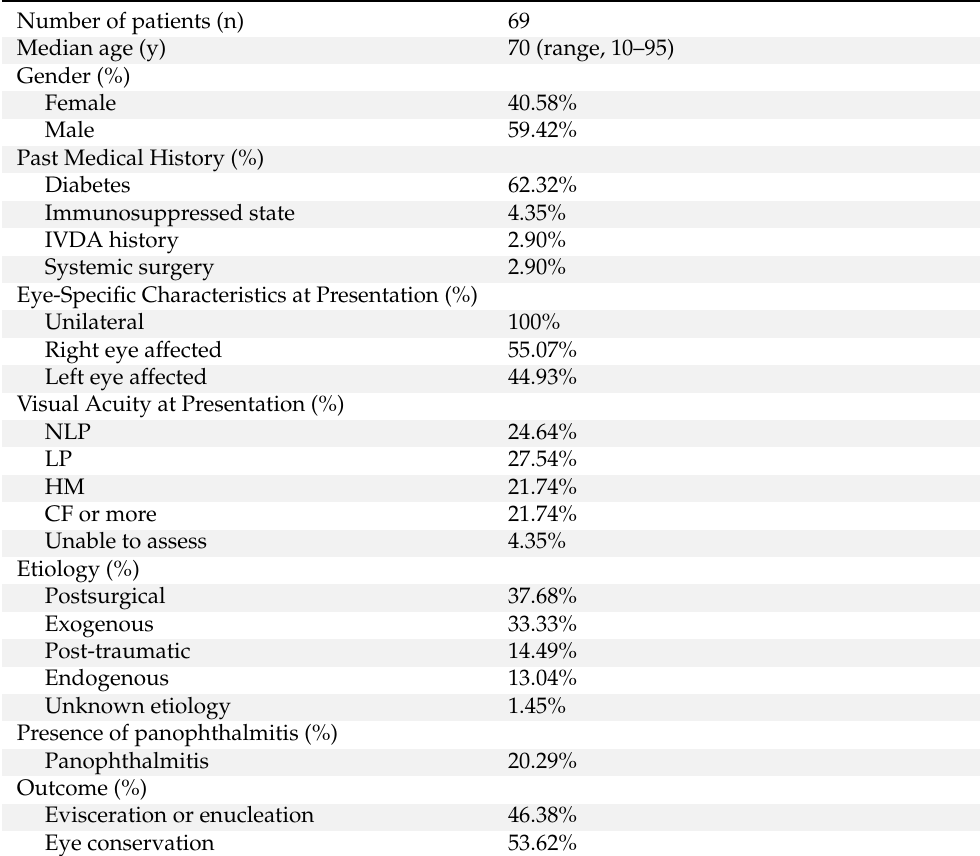
Table 1. Demographic and Clinical Characteristics of Study